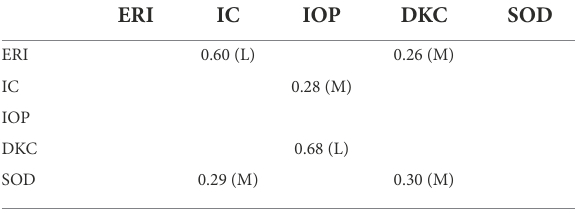
TABLE 6 F2 statistics of construct